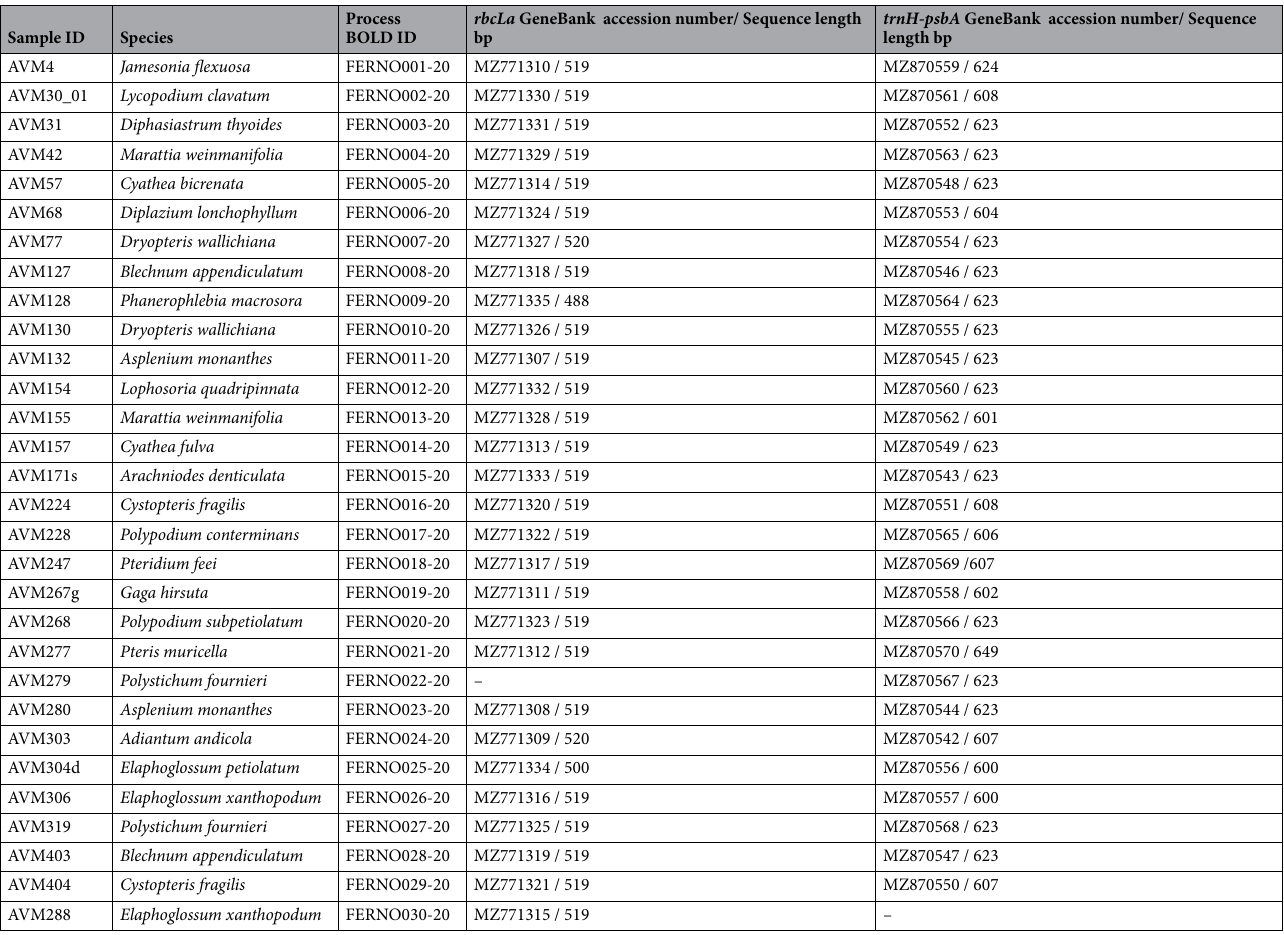
Table 6. Ferns and lycopods of the Mixteca Alta, Oaxaca, with their BOLD ID number and GeneBank accession number obtained from r bcLa and trnH-psbA amplifications, along with their sequence